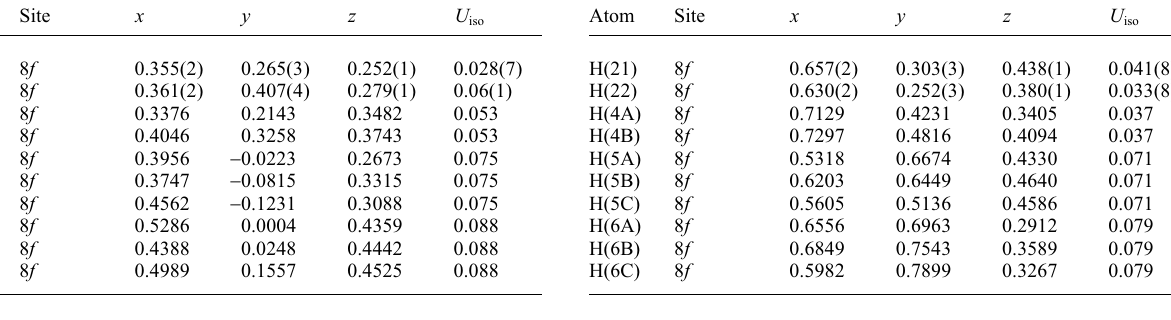
Table 3. Atomic coordinates and displacement parameters (in Å 2 ) .